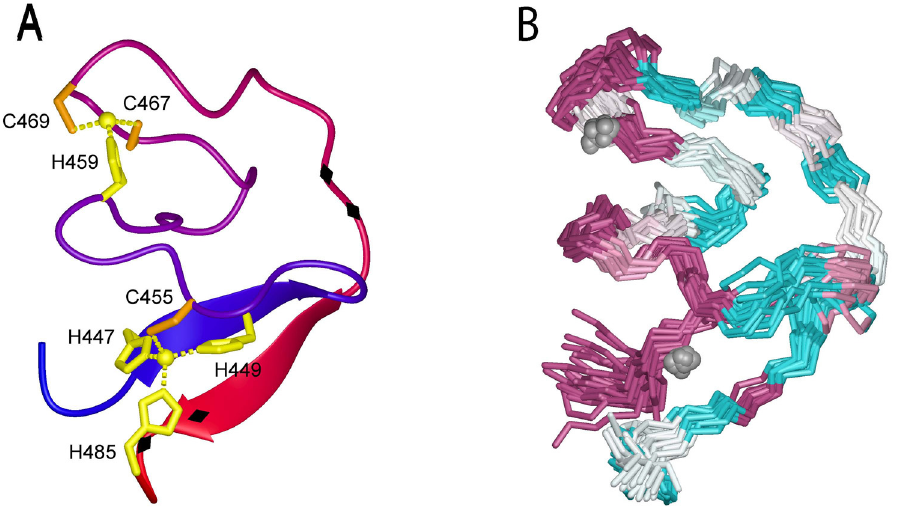
Figure 3. NMR structure of the zinc-binding domain in the cytoplasmic tail of G2. ( A ) Ribbon model of the deduced structure. Coloring changes from blue (N terminus) to red (C terminus). The zinc ions are depicted as spheres, and the coordinating cysteine and histidine sidechains are displayed. Black diamonds on the C-terminal half of the ribbon depict the two pairs of basic residues (KK and RR) implicated in ER retention/retrieval. ( B ) Superimposed backbone traces are colored to indicate the degree of